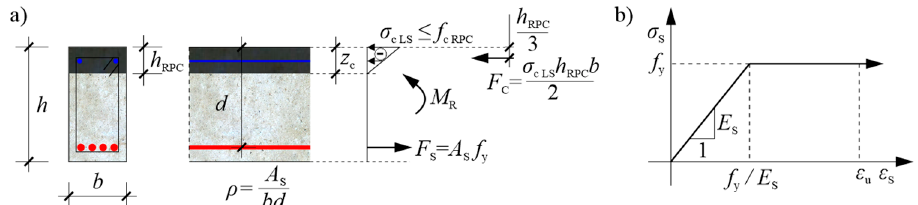
Figure 4. ( a ) Distribution of stresses and their resultants for the assumed ultimate limit state under bending in the reinforced concrete beam strengthened with the RPC layer in the compression zone ( z c is the position of neutral axis as its distance [m] from the beam’s compression face equal the height of RPC layer in the limit state). ( b ) Assumed stress–strain relation in the reinforcing steel (based on [41]).